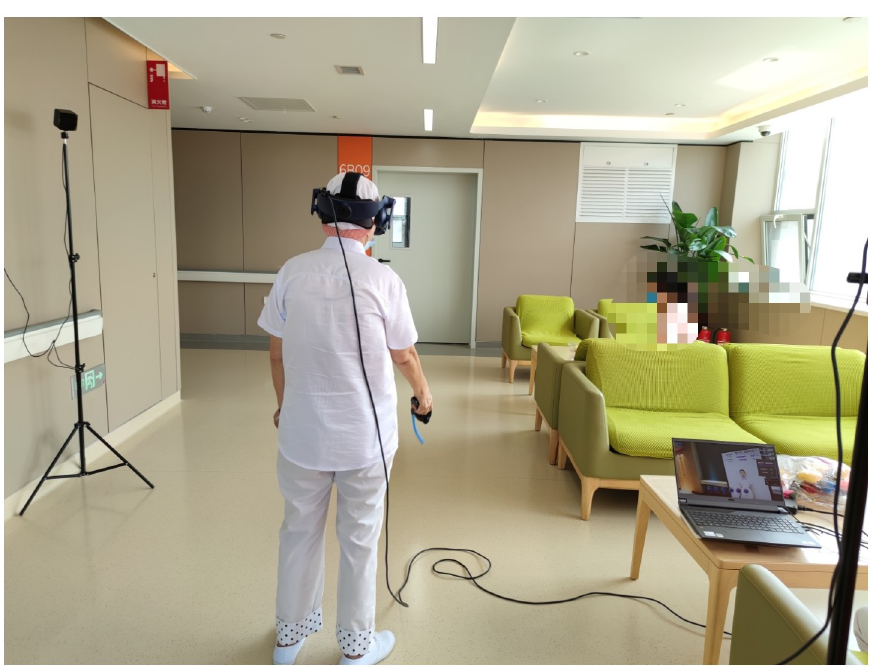
Fig 3. Picture of a patient using the rehabilitation system in the